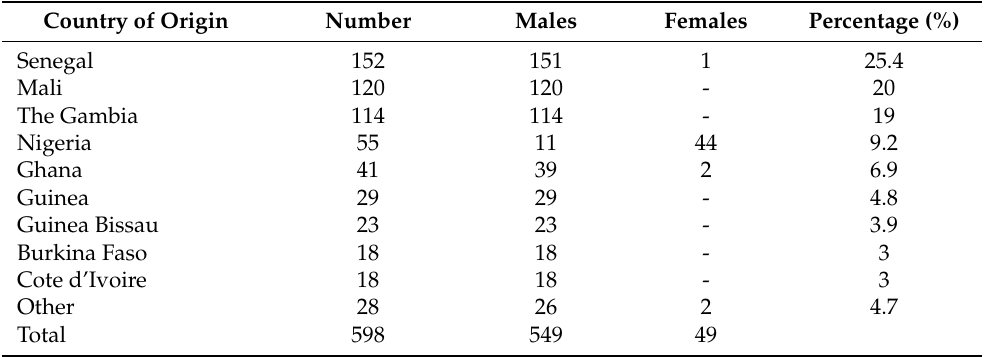
Table 1. Demographic profile of 598 patients from the San Ferdinando settlement who accessed the clinic during the study period.